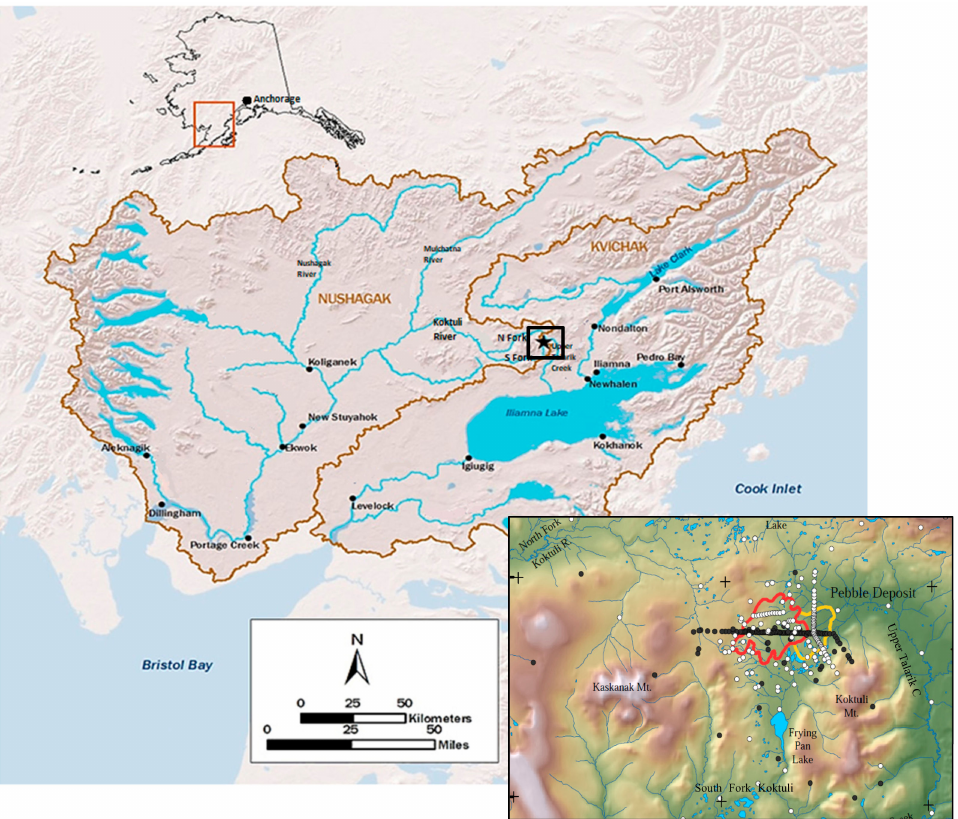
Figure 1. Site location. The location of the mine is shown by the black star (59 ◦ 54’ N, 155 ◦ 23’ W), north of Iliamna Lake. The mine straddles the Nushagak and Kvichak watersheds which both enter Bristol Bay. Inset: red—western zone of mineral deposit, yellow—eastern zone of deposit, black and white dots—U.S. Geological Survey (USGS) sample sites 2007–2008. Main map adapted from [19]; inset map adapted from